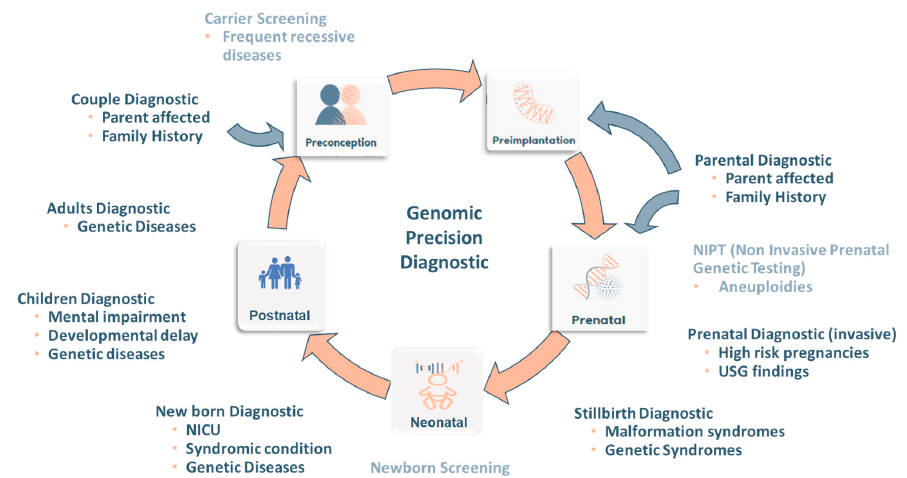
Figure 3. Closing the circle of the Reproductive Journey: Impact of the genomic diagnostic (dark blue) and screening (light blue) application along the different stages of the reproductive journey. Blue-gray arrows show new “access ways” to the reproductive journey driven by a precise diagnostic.